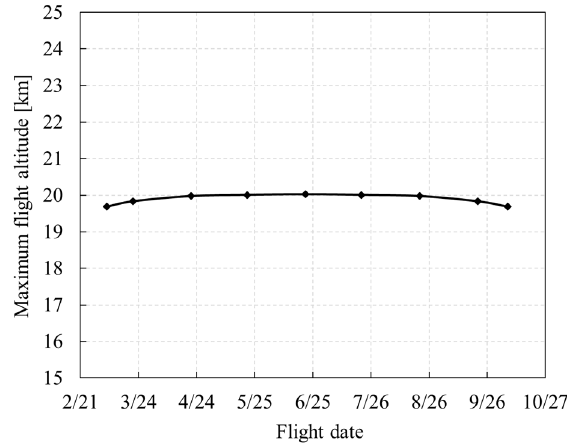
Figure 26. Influence of flight date on maximum flight altitude.